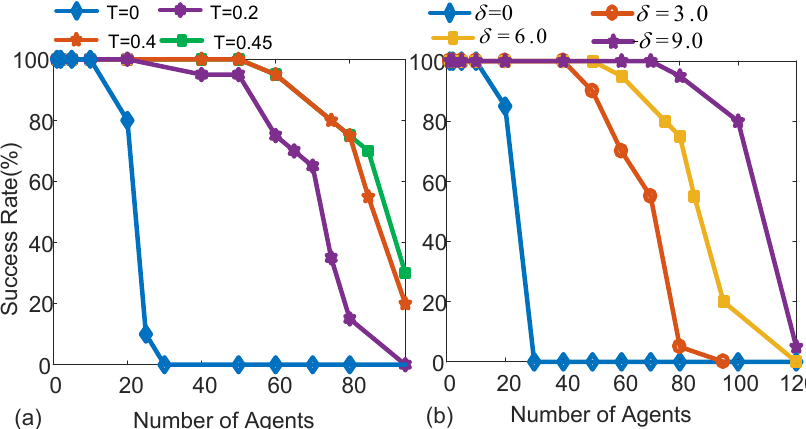
Figure 5. Impact of the collision threshold T (given δ = 6.0) and offset parameter δ (given T = 0.35) on one-resource-one-type